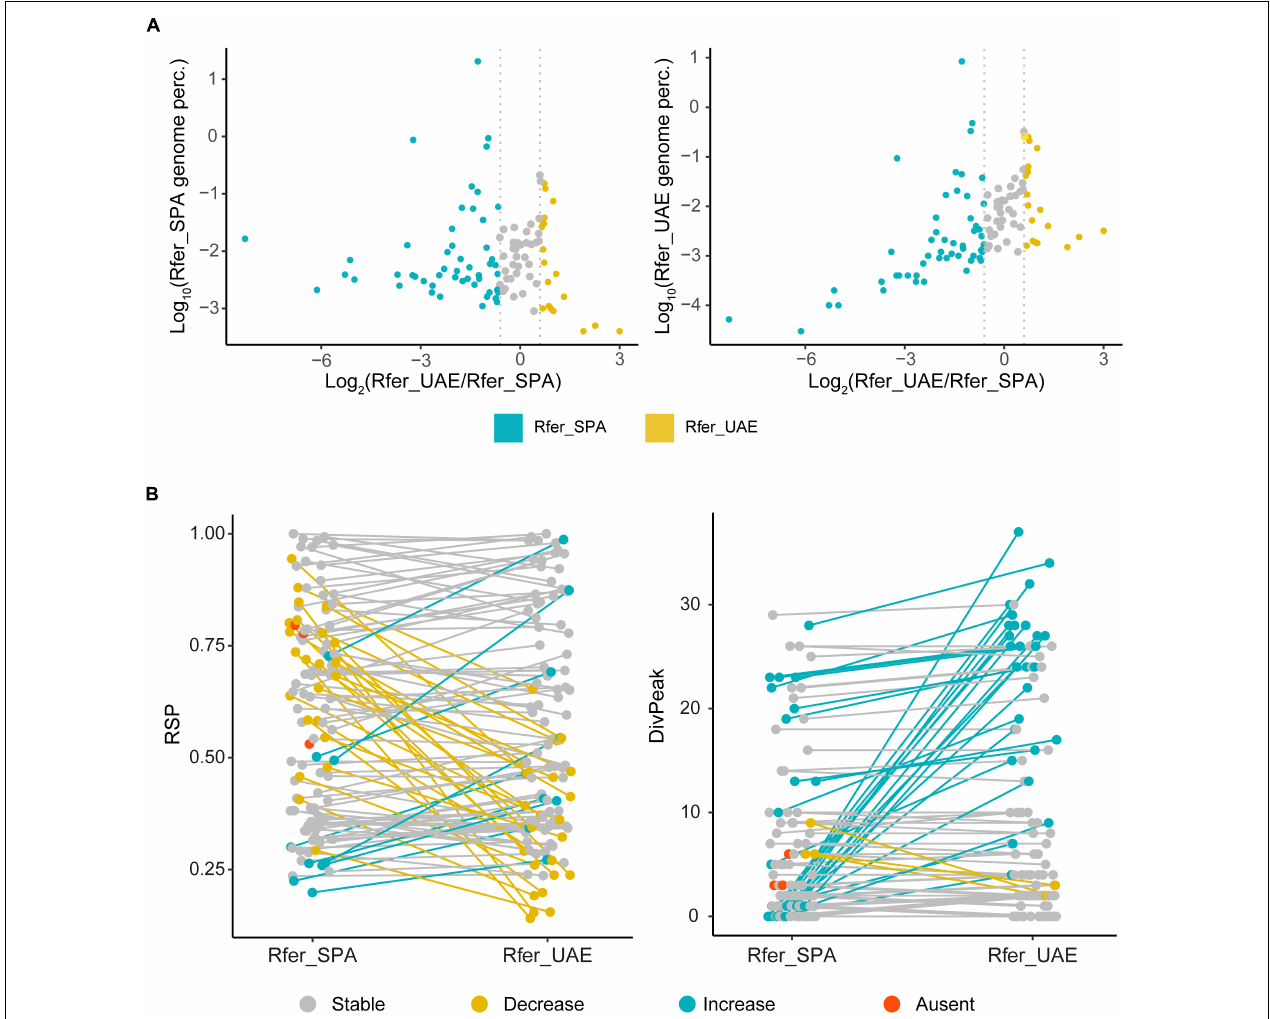
FIGURE 2 | Comparison of satDNA families between Rhynchophorus ferrugineus samples. (A) Genome percentage of satDNA families in each sample against the abundance ratio was depicted. SatDNA families with coefficient of variation below 30% and less of 1.5 fold-change between samples (–0.6 < log 2 ratio < 0.6) are in gray, most abundant satDNA families on Rfer_UAE in yellow and most abundant on Rfer_SPA in blue. (B) SatDNA homogenization indexes, RSP and DivPeak, in Spanish and UAE samples. Changes between samples are represented in colors: families with no variation in gray, decreased in UAE individual in yellow and increased in UAE individual in blue. Families not found in Rfer_UAE are in